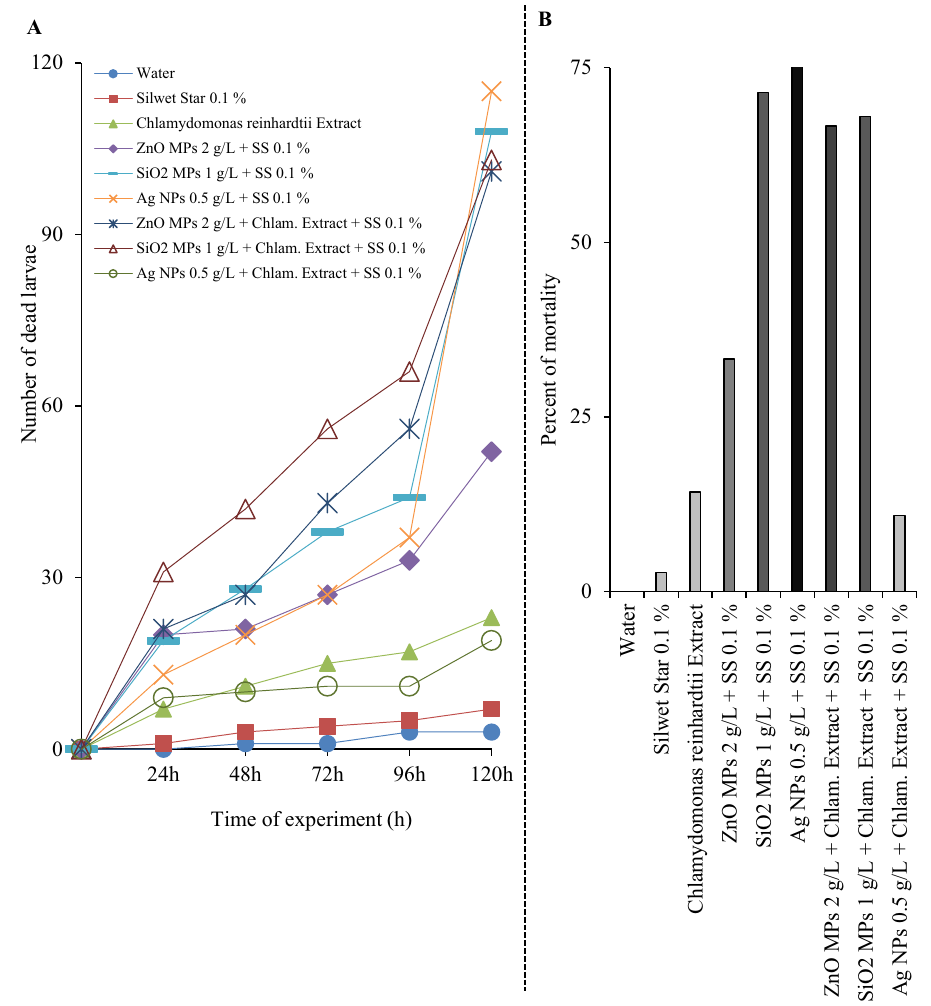
Figure 2. Mortality of Tenebrio molitor larvae after using pure 2 g/L ZnO MPs, 1 g/L SiO 2 MPs and 0.5 g/L Ag NPs and these MPs/NPs in combination with Chlamydomonas reinhardtii extract. (A) Number of dead larvae for 5 days. Three spray treatments: 0, 48 h, 96 h. 150 mealworms were used per treatment. (B) Percent of total mortality after 120 h. Mortality was measured by the Henderson-Tilton formula 20 .